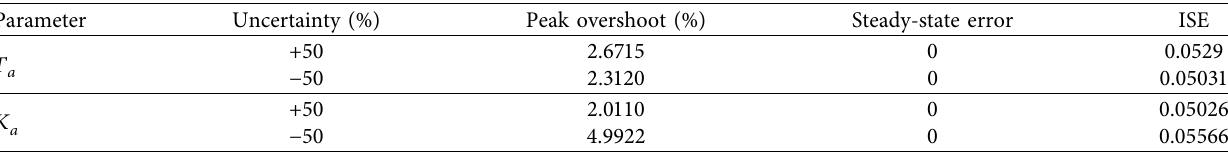
Table 6: Robust response specifcation of MESOBC-based AVR under ± 50% uncertainties in amplifer. Parameter Uncertainty (%) Peak overshoot (%) Steady-state error ISE +50 T a